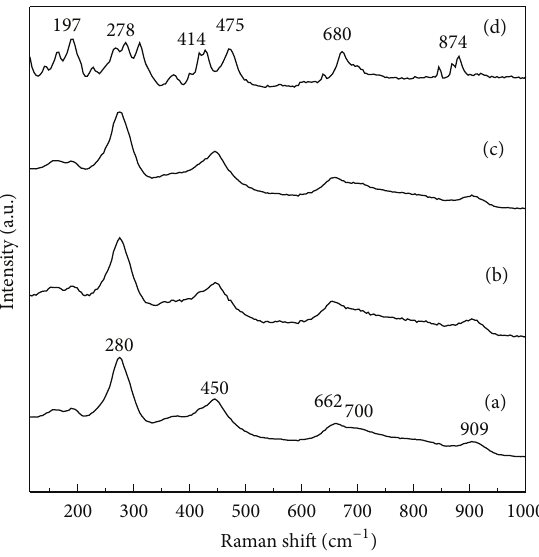
Figure 10: UV-Visible spectra of the dye at different concentrations at room temperature: 0, 3, 6, 9, 12, 15, and 18mg/L.